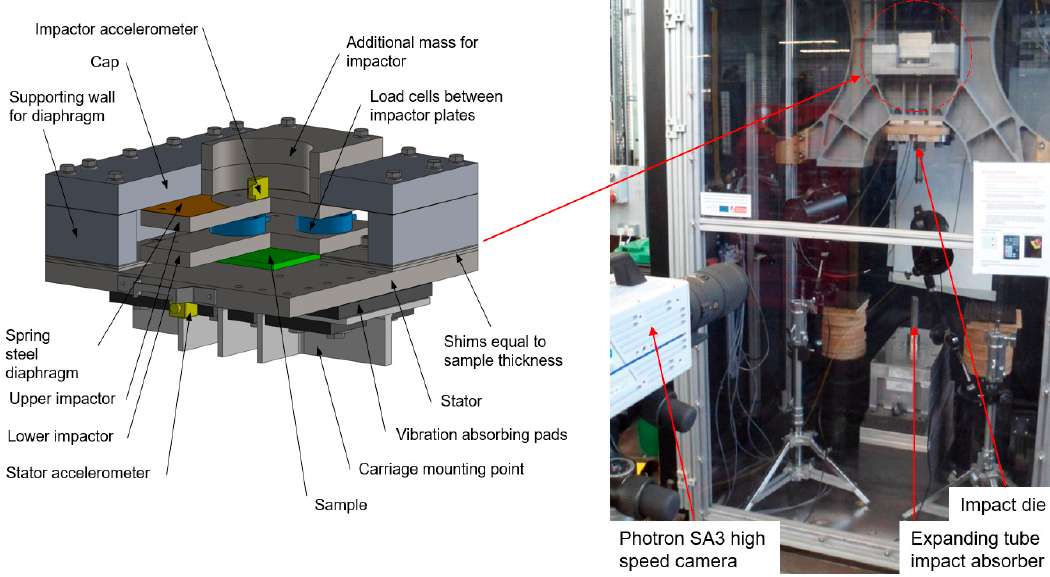
Figure 2. Summary of experimental apparatus for compression impulse testing.